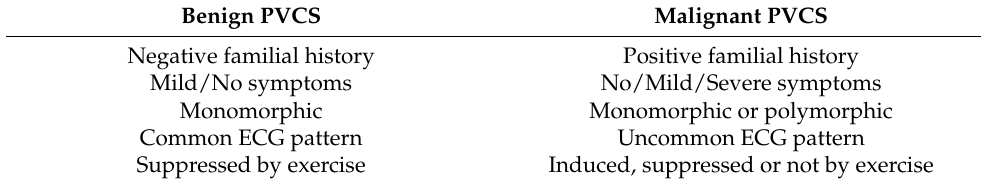
Table 1. Characteristics of benign and malignant premature ventricular contractions (PVCs).